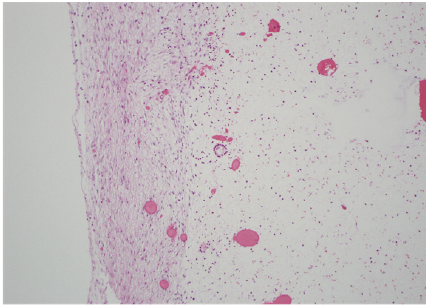
Figure 2: Medium power view showing an ovarian follicle sur- rounded by edema.